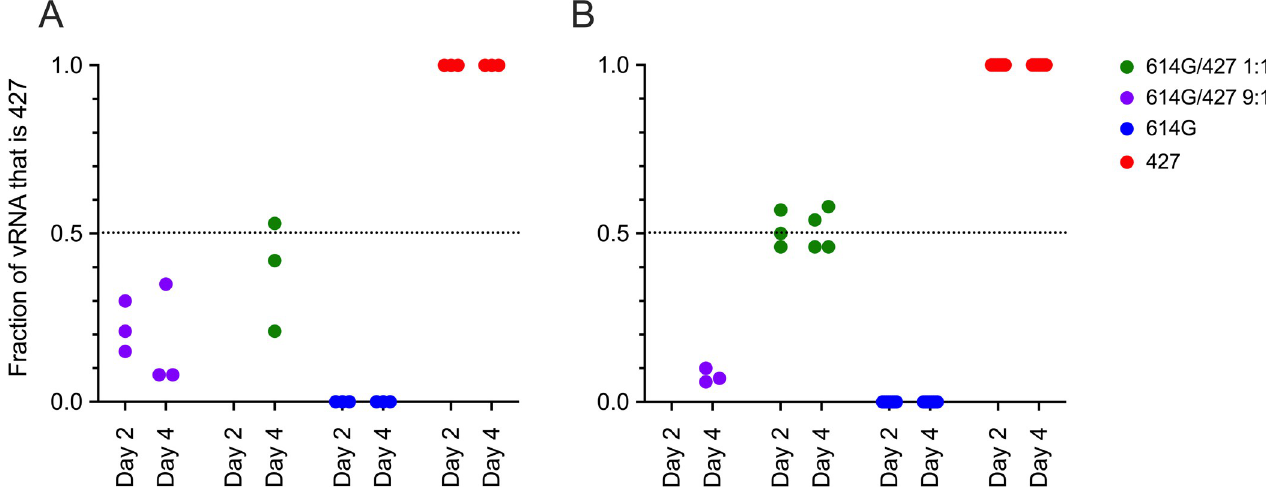
Fig 6. The proportion of each virus in hamsters after intranasal inoculation with a 1:1 or 9:1 mixed inoculum of B.1 (614G) and B.1.427; and sgRNA levels in hamsters inoculated with a mixed inoculum of 7 SARS-CoV-2 variants: B.1 (614G), B.1.427, B.1.427, P.1, P.2, B.1.1.7 and B.1.351. A) proportion of the vRNA in URT washes collected at necropsy at 2 and 4 days PI that was B.1.427. B) proportion of the vRNA in lung collected at necropsy at 2 and 4 days PI that was